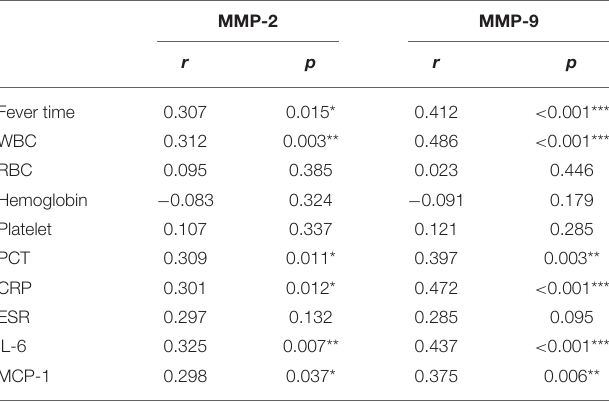
TABLE 5 | Correlations analysis between MMP-2 and MMP-9 levels and clinical parameters in KD